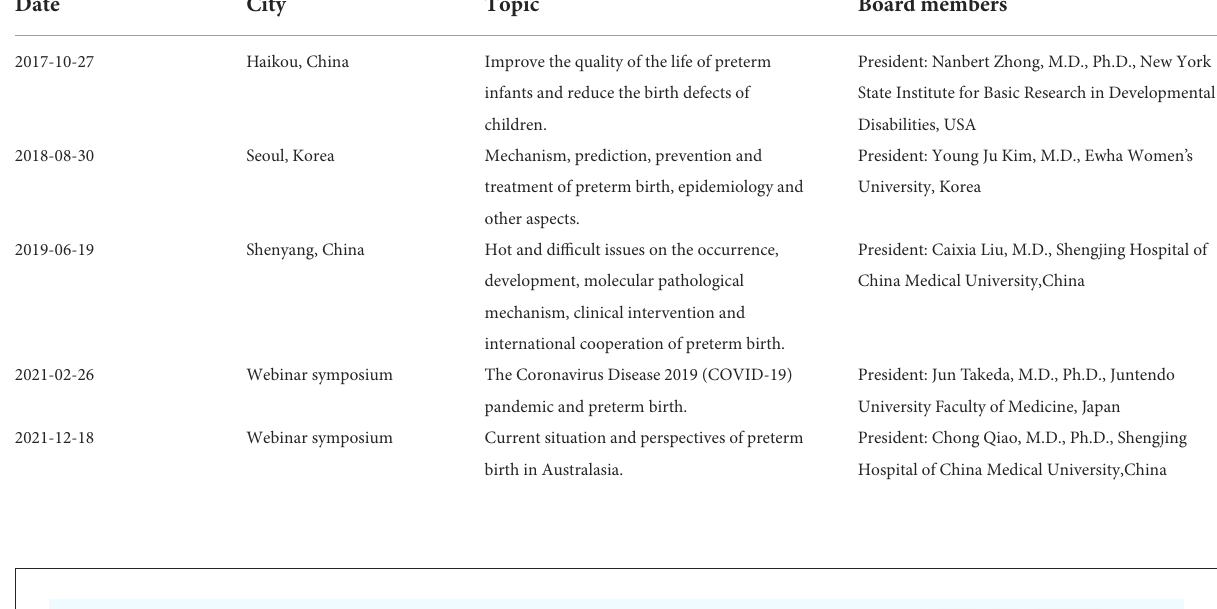
TABLE 1 History of PREBIC-AA symposium.